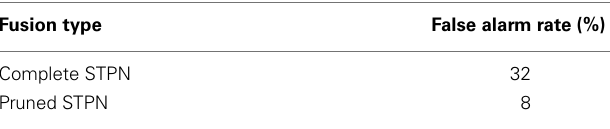
Table 4 | Comparison of false alarm rate generated by exhaustive sensor fusion (complete STPN) and pruned STPN .